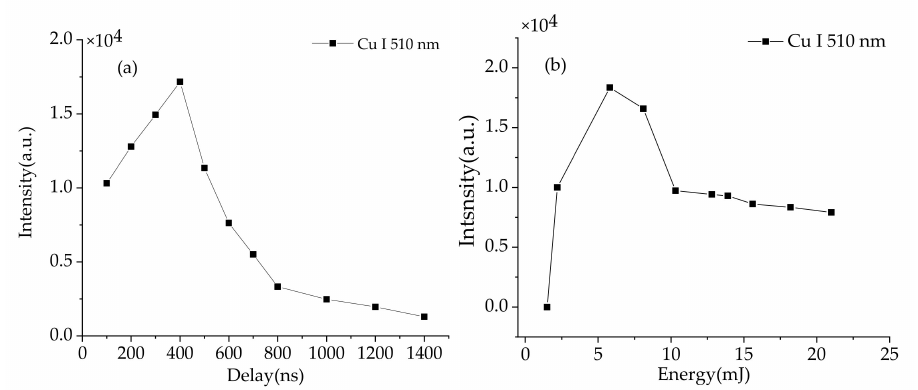
Figure 2. ( a ) Spectral intensity of Cu I 510 nm under di ff erent delay time. ( b ) Spectral intensity of Cu I 510 nm under di ff erent laser